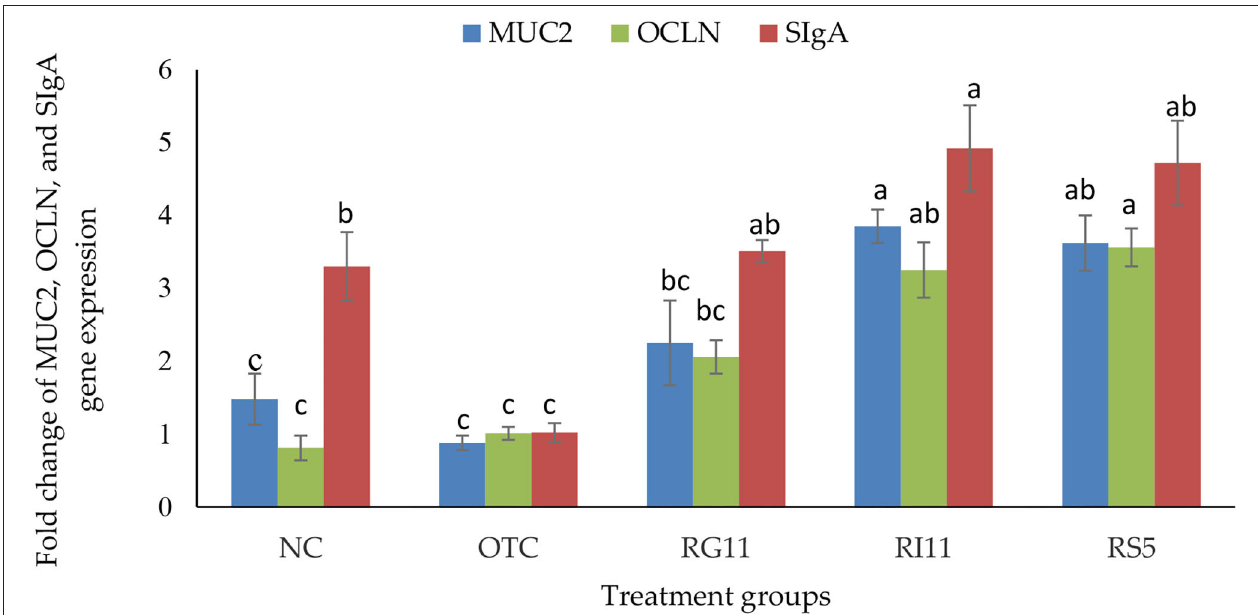
FIGURE 2 | Gene expression of jejunal MUC2, OCLN, and SIgA in broiler chickens when supplemented with different postbiotics. abc Bar with different superscripts differ significantly at p < 0.05. Treatment groups: NC: basal diet only (negative control), OTC: basal diet + 0.01% oxytetracycline (positive control), RG11: basal diet + 0.1% Postbiotic RG11, RI11: basal diet + 0.1% Postbiotic RI11, RS5: basal diet + Postbiotic